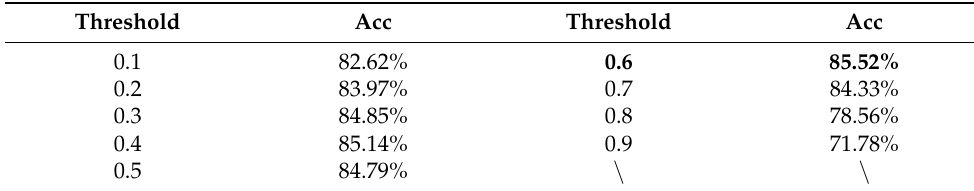
Table 1. Similarity threshold of our network for face